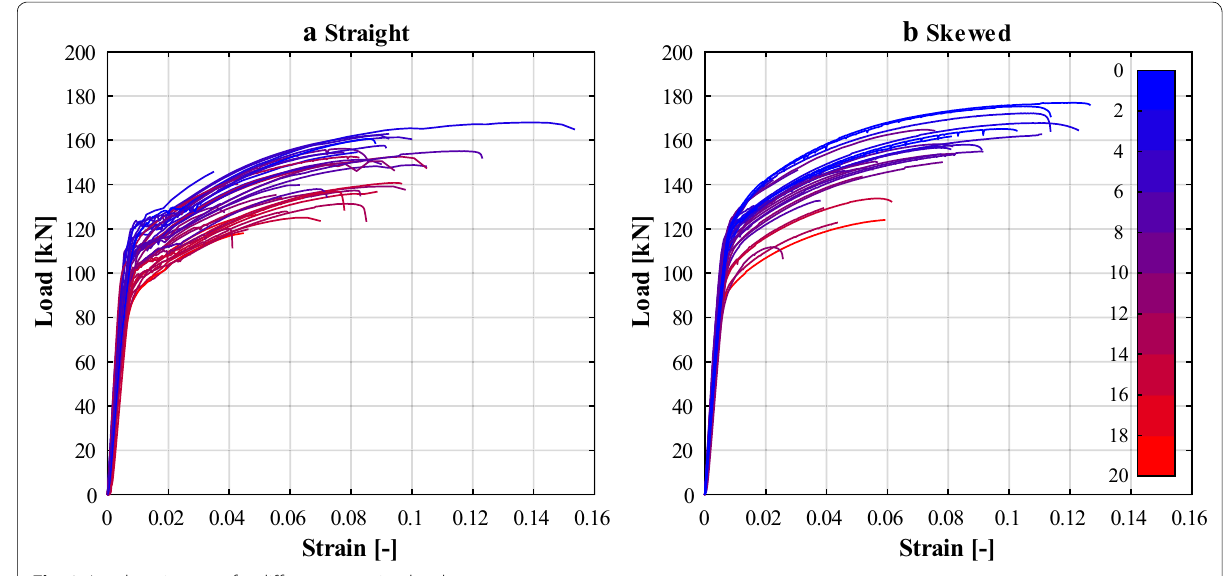
Fig. 9 Load-strain curve for different corrosion